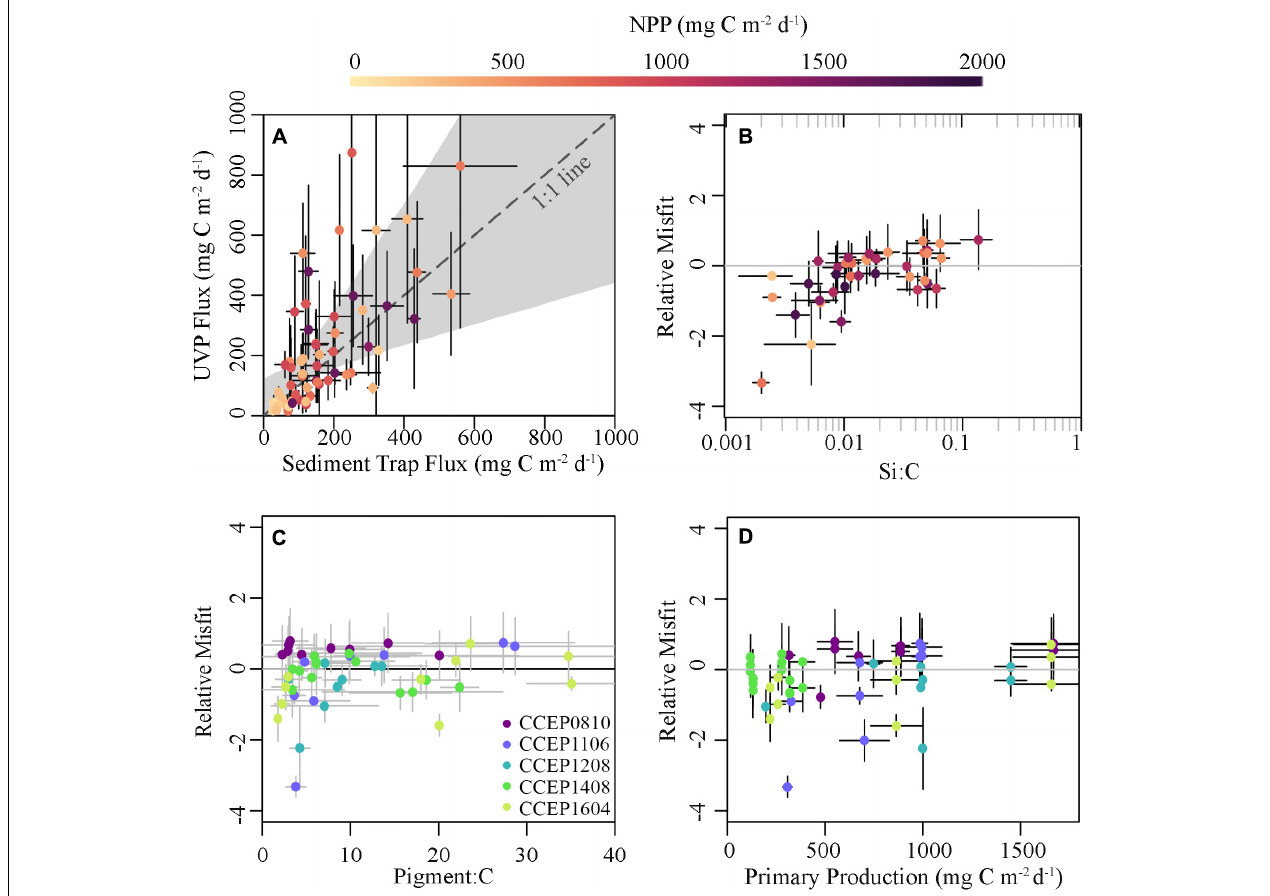
FIGURE 8 | (A) Comparison of cycle averaged flux estimates derived from sediment trap deployments and the CCE-optimized UVP algorithm using fitted A and B values of 15.4 and 1.05 respectively with points colored based on primary productivity. The calculated relative misfit [i.e., (F UVP – F ST )/F UVP ] plotted against (B) the Si:C ratio of sinking material, (C) the pigment:carbon ratio of sinking material, and (D)